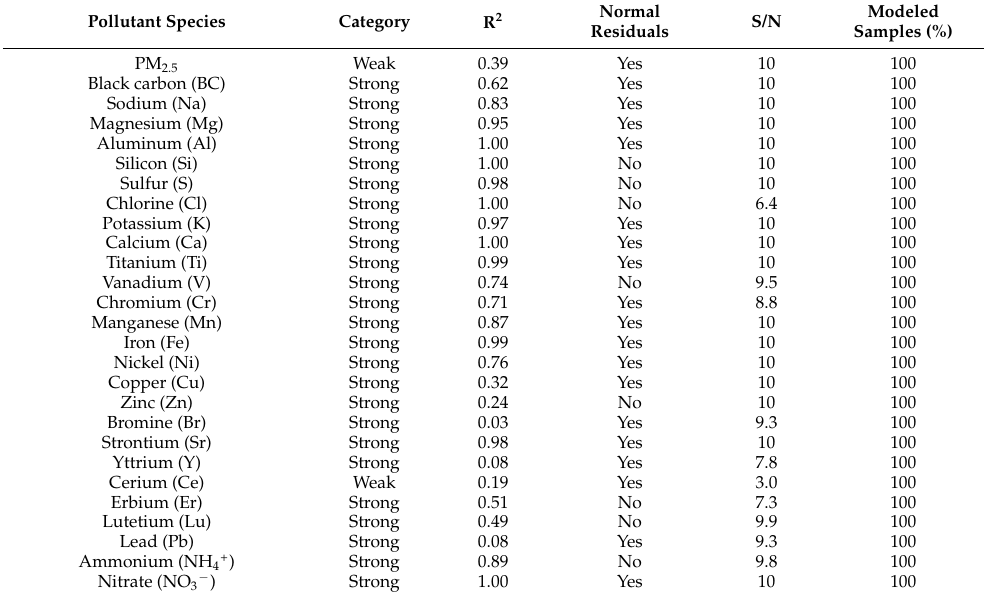
Table 2. Signal-to-noise ratios (S/N), categories, and distribution of residuals for the pollutant species used for positive matrix factorization (PMF)